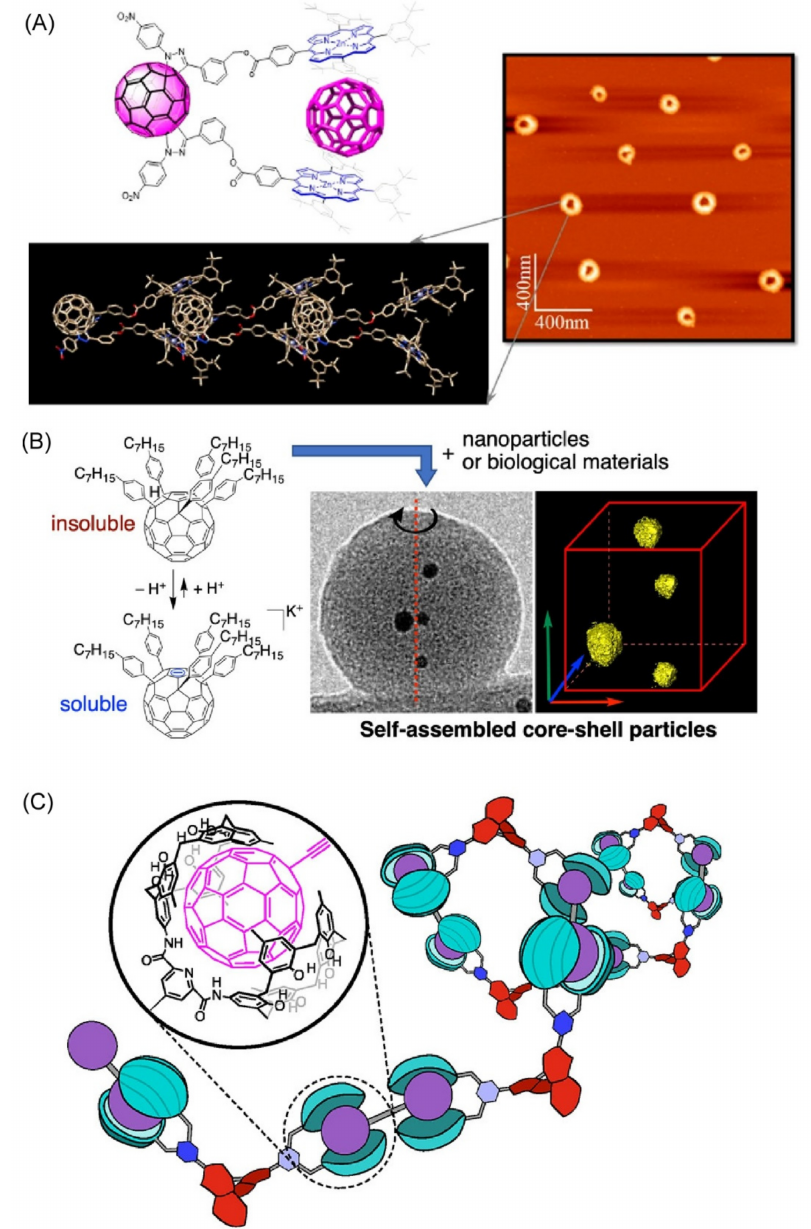
Figure 11. Fullerene-based assembly: ( A ) fullerene-bis-zinc-porphyrin electronic double adduct hier- archically structured to form doughnut-shaped aggregates; ( B ) protonated (4-heptylphenyl) 5 C 60 H self-assembly into fullerspheres (fullerene spheres); and ( C ) helically aligned fullerenes by supramolecular polymerization of a chiral ditopic tetrakiscalix[5]arene host and dumbbell-type fullerenes. Reproduced under terms of the CC-BY license [160]. Copyright 2021, American Chem- ical Society. Reprinted with permission from [161]. Copyright 2021, American Chemical Society. Reprinted with permission from [162]. Copyright 2021, American Chemical